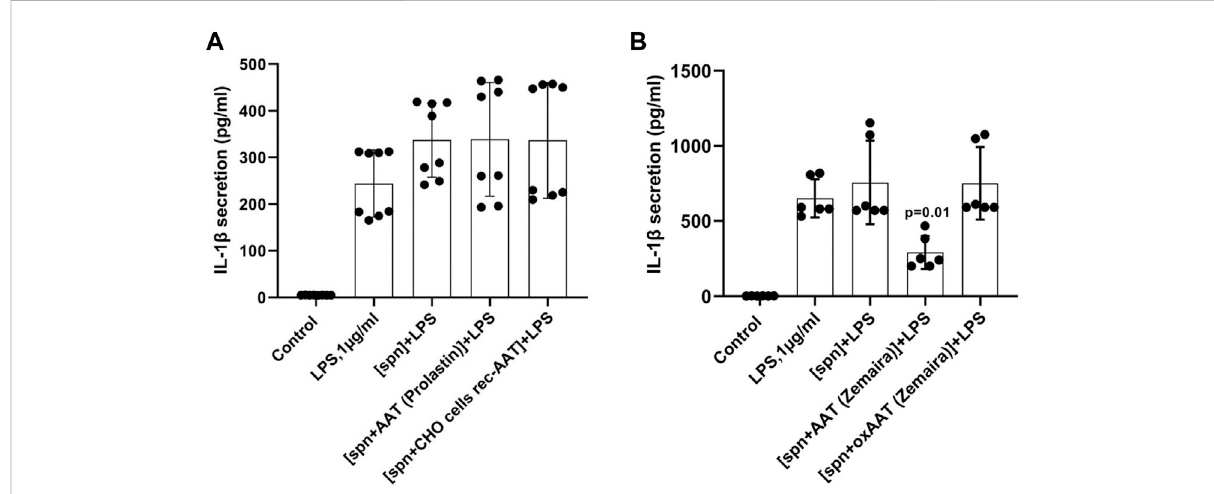
FIGURE 4 PBMCsinresponsetoLPSdidnotchangethereleaseorexpressionofIL-1 β whenculturedin fi lteredsupernatantsfromPBMCspre-treatedwith AAT preparations other than AAT (Zemaira ® ) (A) or oxidized AAT (Zemaira ® ) [oxAAT (Zemaira ® )] (B) . (A) LPS-induced IL-1 β secretion in total human PBMCs cultured for 6 h in supernatants from autologous PBMCs pre-treated for 30 min with PBS [spn] or with AAT (Prolastin ® ) or recombinant humanAAT(CHO-recAAT,4 mg/ml),[spn+CHOcellsrec-AAT].Eachbarrepresentsthemean(SD)fromfourindependentdonorexperiments, with two repeats for each. (B) LPS-induced IL-1 β secretion in total human PBMCs cultured for 6 h in supernatants from autologous PBMCs pre- treated for 30 min with PBS [spn] or with AAT (Zemaira ® ) or oxidized [ox AAT (Zemaira ® ]. Each bar represents the mean (SD) from three independent donor experiments, with two repeats for each. p -value indicates signi fi cance between LPS and [spn + AAT (Zemaira ® )+LPS].